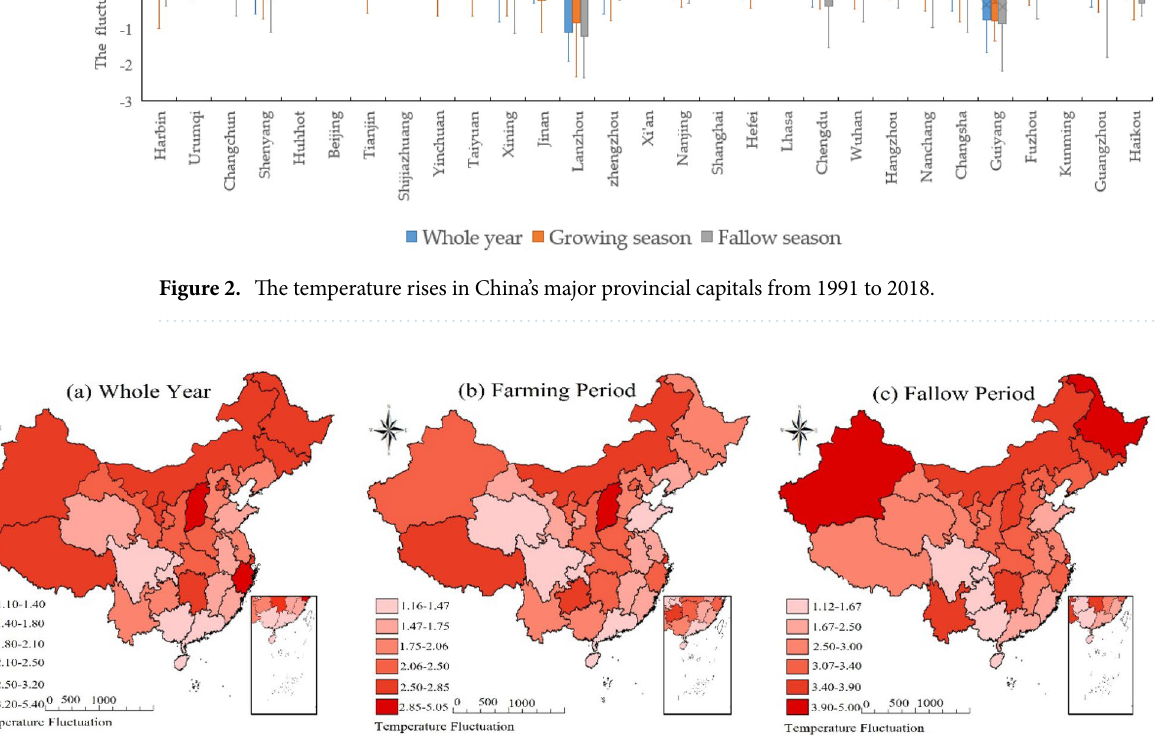
Figure 3. Distribution of high temperature fluctuations in main provincial cities in China (regional maximum temperature—regional historical average